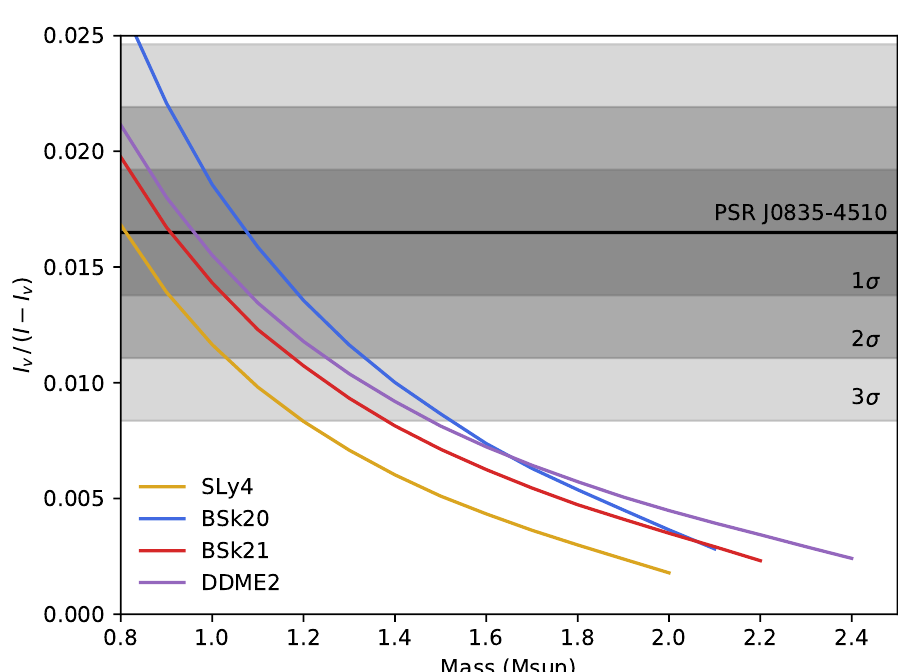
Figure 4. Activity constraint on the superfluid component moment of inertia plotted for some EoSs: SLy4 [54], BSk20 and BSk21 [55], and the DDME2 EoS [56], glued with a SLy4 crust following the method described in [57]. The entrainment parameter is that calculated in [32], and the superfluid reservoir is limited in the crust of the star. The dimensionless activity parameter G —calculated with the bootstrap method described in Section 2 (the case with random glitch sizes and waiting times)—is also plotted for the Vela pulsar, along with the 1 σ , 2 σ and 3 σ